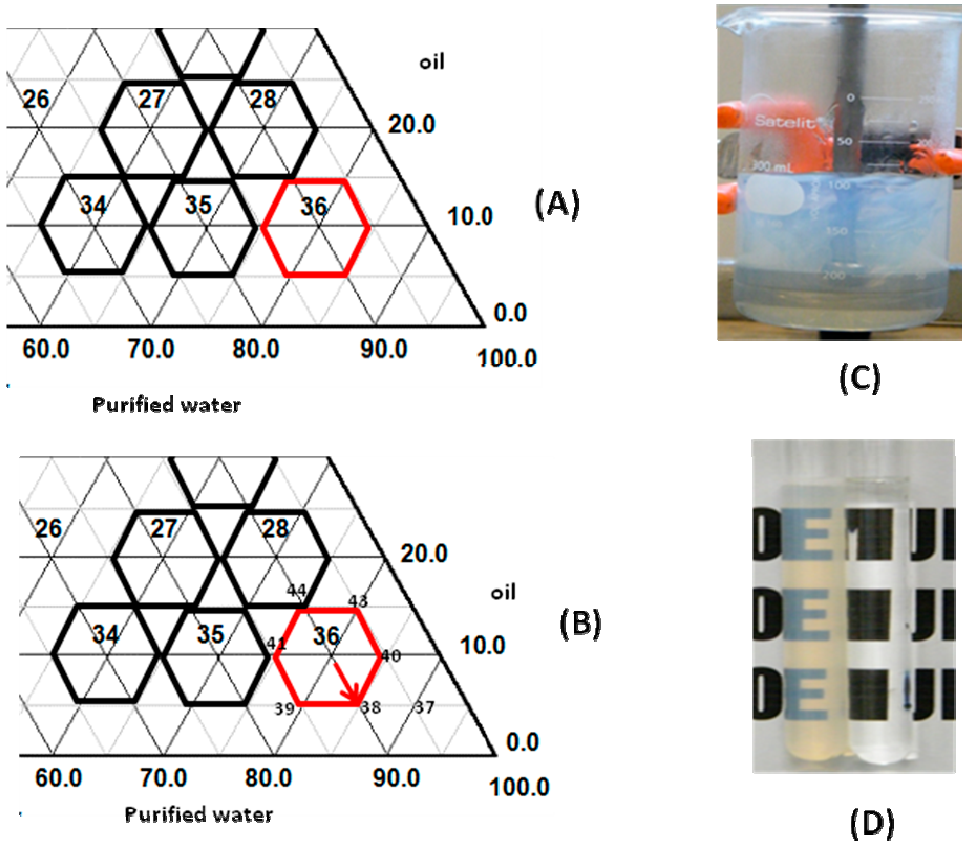
Figure 1. ( A ) Details of the phase diagram for babassu oil/water; ( B ) phase diagram—5.0% to 5.0%/surfactant (castor oil 54 EO/sorbitan monooleate, HLB value = 10.0); ( C ) nanoemulsion preparation; and ( D ) nanoemulsion.